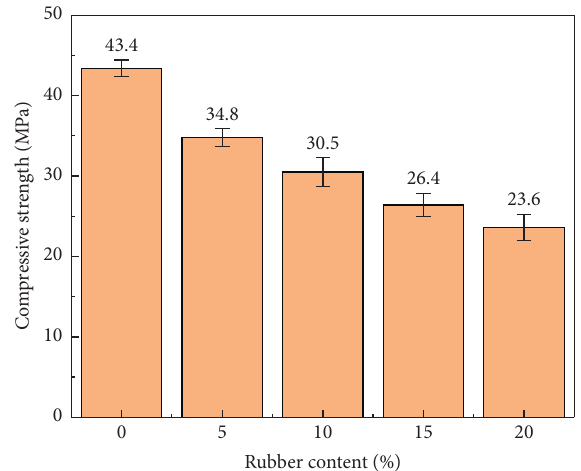
Figure 4: 28-day compressive strength of fiber concrete with different rubber contents.